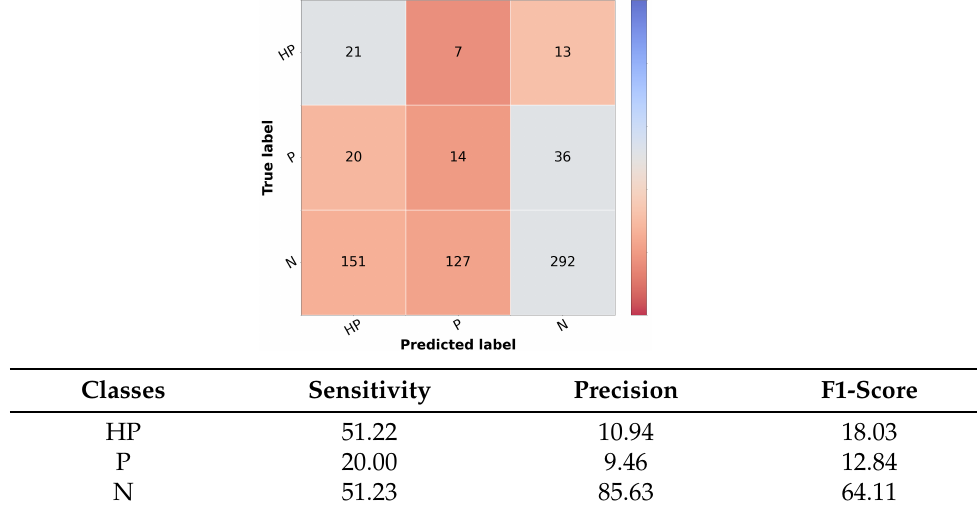
Table 10. Resulting metrics and confusion matrix of test set 1 for baseline priority model (in